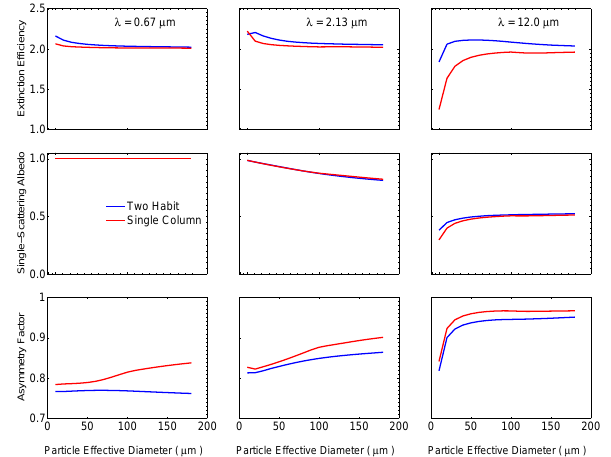
Figure 9. Bulk extinction efficiency (upper), single-scattering albedo (middle), and asymmetry factor (lower) of the two-habit model and the single-column model at wavelengths 0.67, 2.13 and 12.0µm.